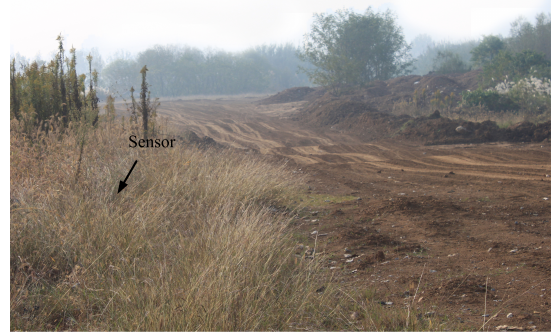
Figure 8. The environment of the field